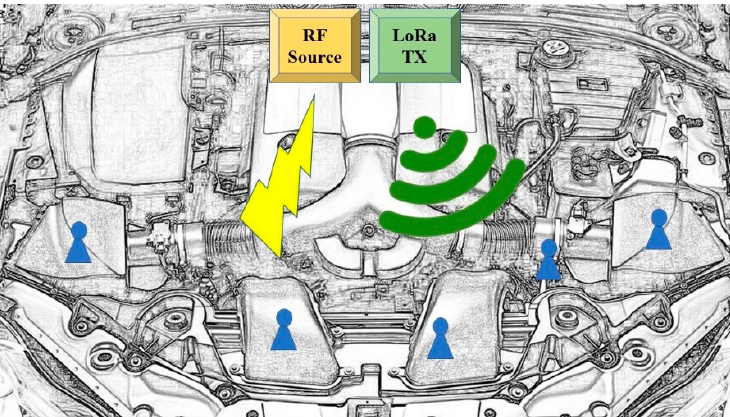
Figure 1. Illustrative example of the envisioned scenario for a WSN system energized by WPT technology in a harsh automotive scenario. The sensor nodes are represented in blue, the power source (yellow), and the communication hub (green) are also shown in one of the possible loca- tions.